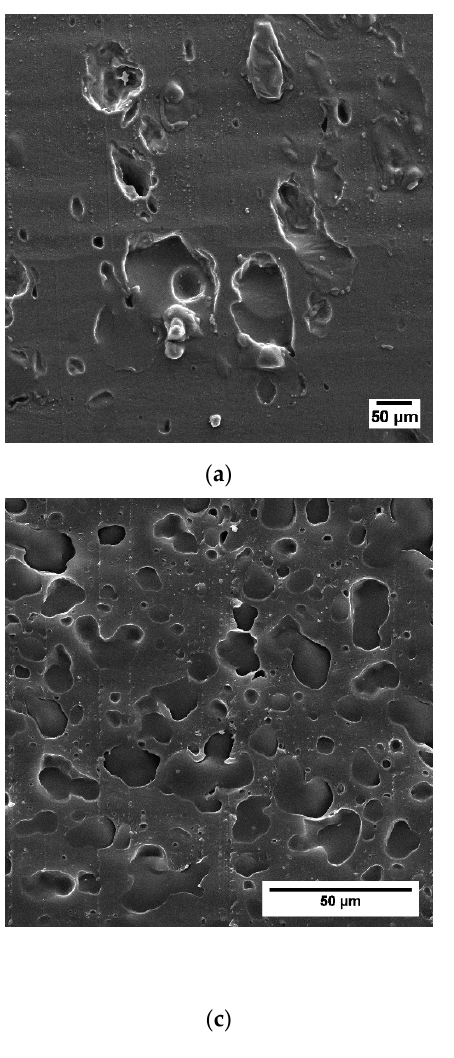
Figure 7. Cryo-sliced surfaces of the blends with 20 wt % SBO inside the soft phase. ( a ) Without EMAGMA and TBEC, ( b ) with 1 phr TBEC, ( c ) with 5 pph EMAGMA, and ( d ) with 5 pph EMAGMA and 1 phr TBEC.